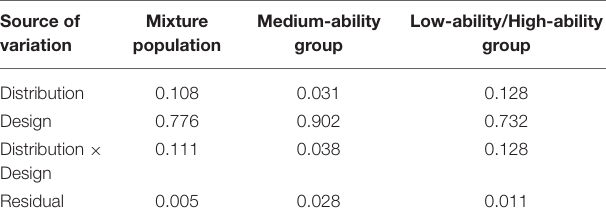
TABLE 5 | Effect sizes ( η 2 ) for main effects and interactions of the factors distribution and design on RMSE( ˆ θ